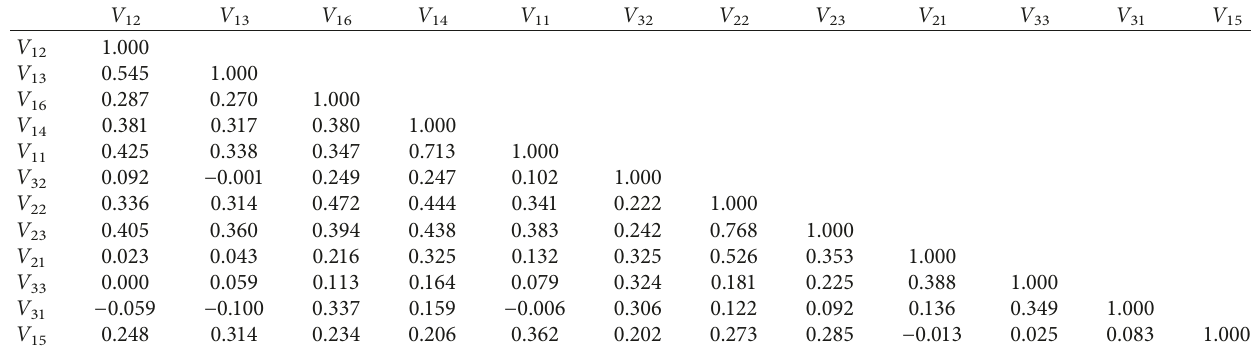
Table 9: Correlation matrix of the 12 input variables.